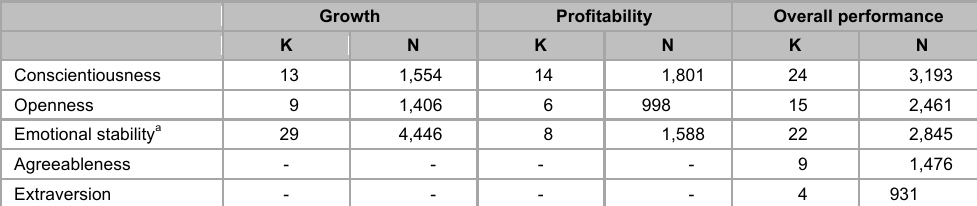
Summary of Zhao et al. (2010) collection of past FFM-FIRM Performance